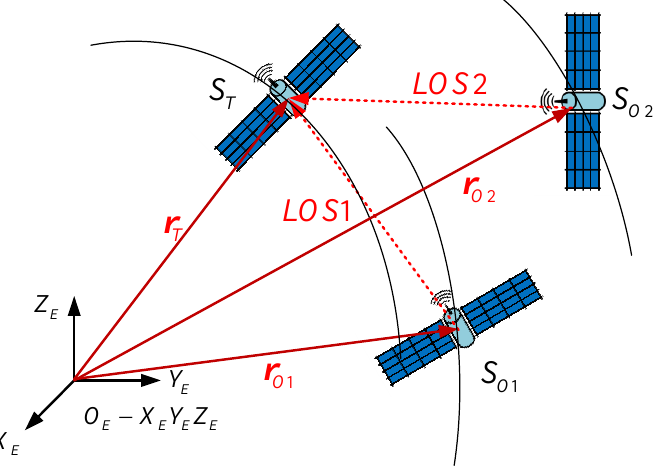
Figure 7. LOS measurement model for a cooperative OD system with an additional observer.